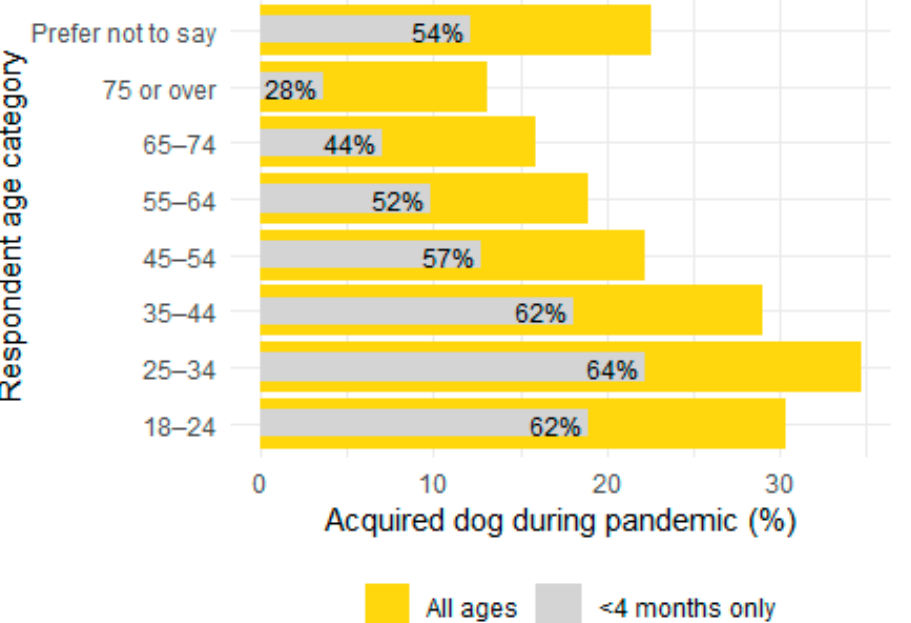
Figure 6. Percentage of age groups that acquired their dogs during the pandemic and of those that were acquired at less than 4 months of age .